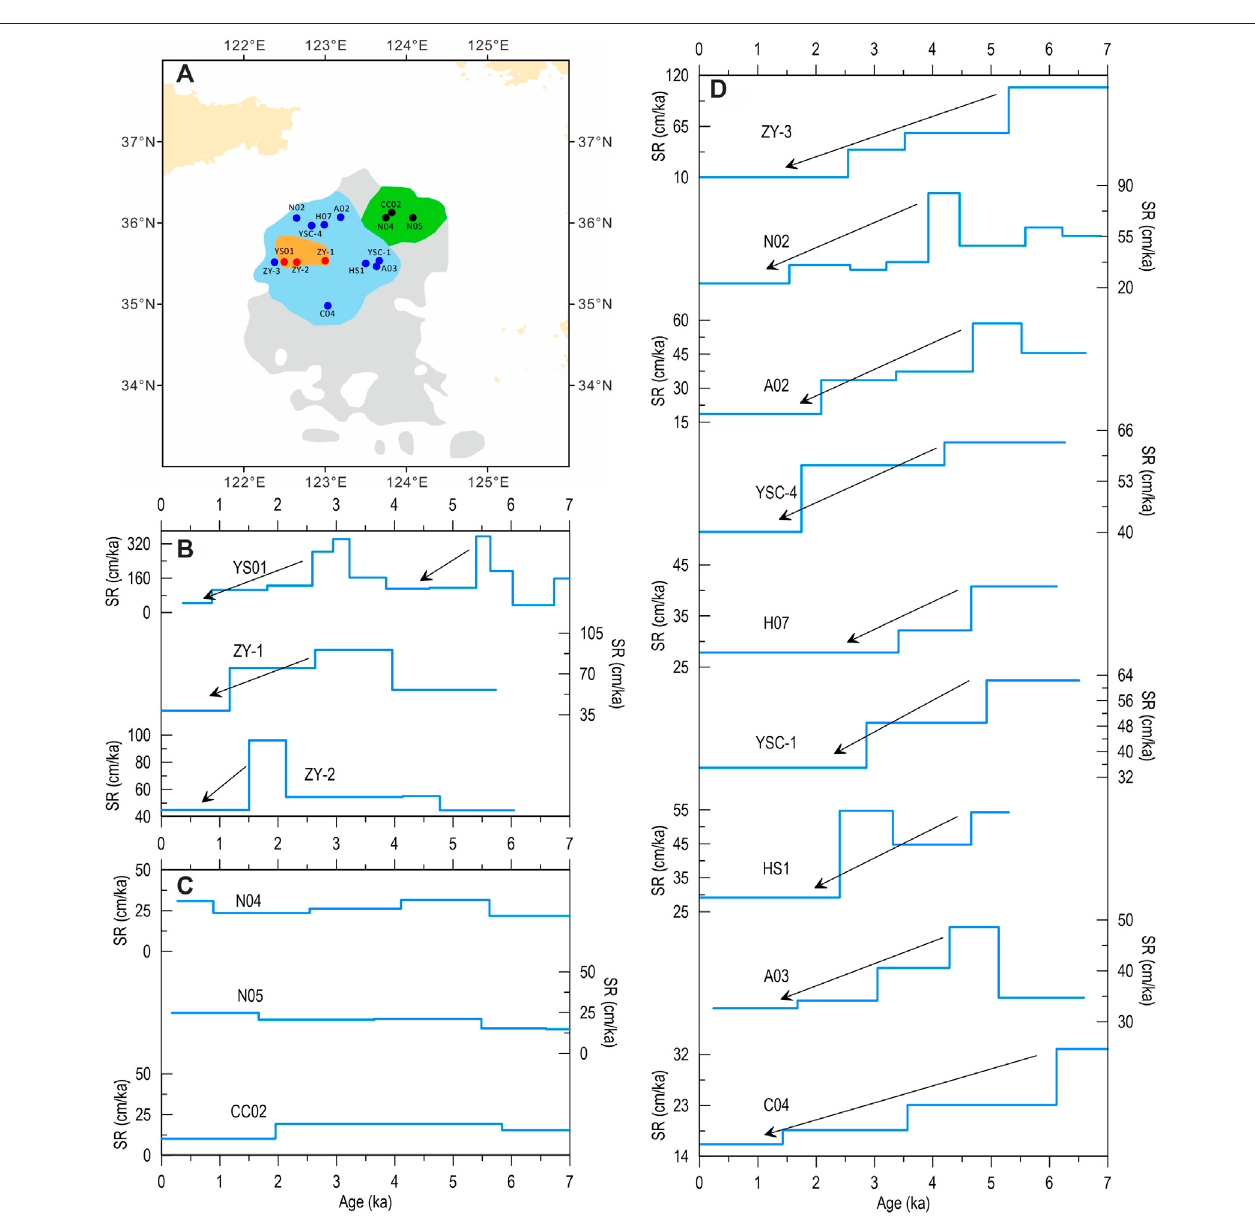
FIGURE 4 | (A) Schematic diagram of the spatial distribution of Holocene mud sedimentary rates [SR; orange area: the depocenter subarea; light blue toroid polygon: the adjacent subarea; green area: the peripheral subarea; gray area: the CYSM zone, modi fi ed from (Li G. et al., 2014) and (Yang et al., 2018)]; (B – D) 14 C stratigraphy of 15 cores in the CYSM zone [YS01 (Jia et al., 2019; Wang Y. et al., 2014; Wang et al. 2020, ZY-1 (Hu et al., 2012), ZY-2 (Hu et al., 2012), ZY-3 (Hu et al., 2012), N02 (Hao et al., 2017; Zhong et al., 2018), A02 (Gong et al., 2017; Wu et al., 2019; this study), YSC-4 (Li J. et al., 2014), H07 (Leng et al., 2017), YSC-1 (Li J. et al., 2014), HS1 (Ai et al., 2020), A03 (Jia et al., 2019), C04 (this study)].